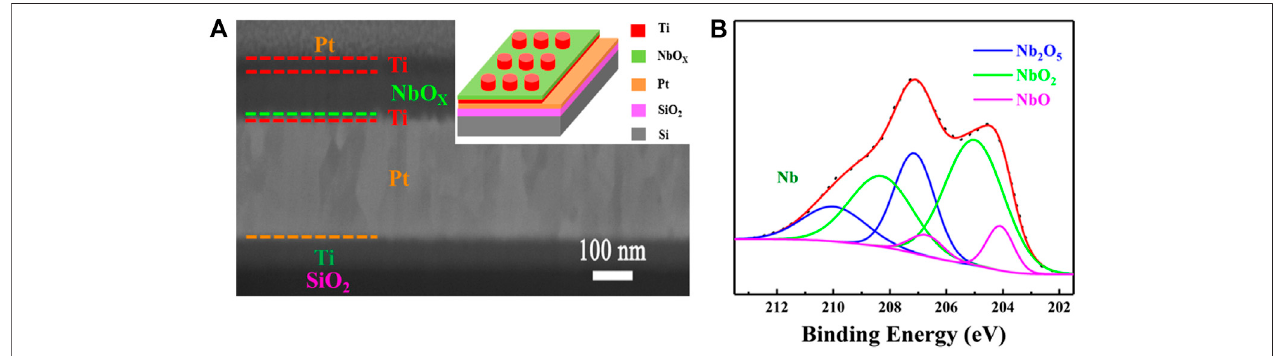
FIGURE 1 | (A) SEM image of the Ti/NbO x /Ti/Pt device measured by crossbeam 540, sketches shown in insets. (B) XPS spectra of Nb3d of the